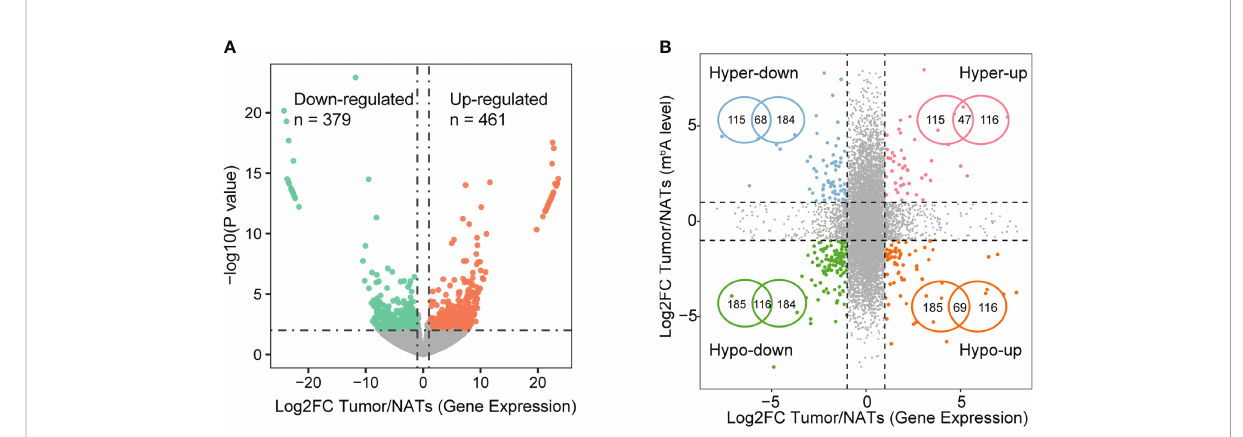
FIGURE 2 Expression alterations modulated by m 6 A signal. (A) Volcano plot of differentially expressed genes based on p-value< 0.01 and |log2FC| > 1. (B) Four-quadrant plots (left) showing genes with signi fi cant changes in both m 6 A levels and expression levels in tumors compared with NATs. Signi fi cance signals correspond to DEG and differential m 6 A methylation as follows: peaks with FDR< 0.05 and |log2FC| > 2, genes with p-value< 0.01 and |log2FC| > 1. Venn diagrams (right) showing the overlapping hyper- and hypo-methylated genes with signi fi cantly differential